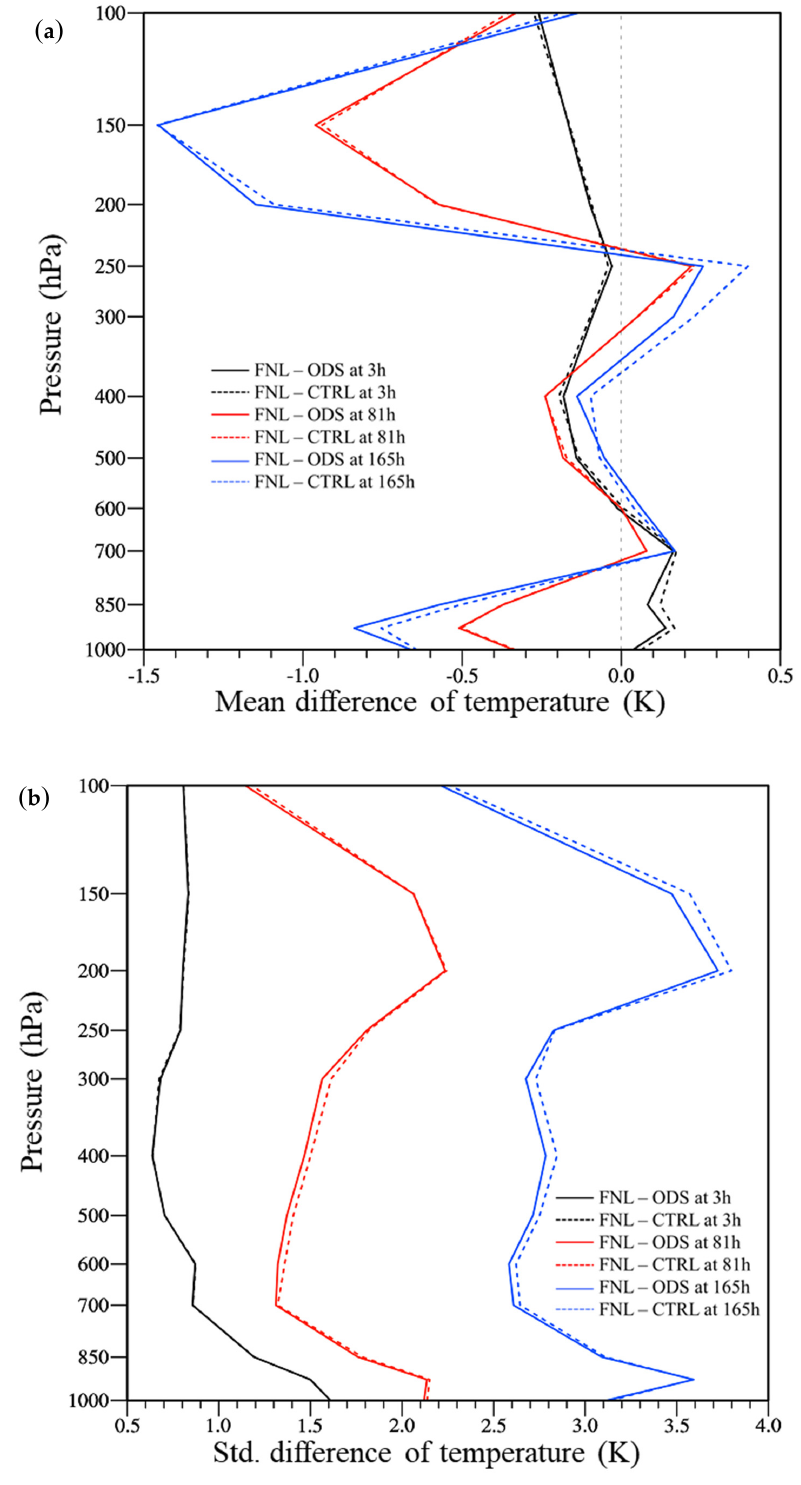
Figure 9. ( a ) Mean biases and ( b ) standard deviations of the vertical di ff erences of temperature between the FNL and forecast data (FNL − ODS, solid lines; FNL-CTRL, dashed) at 3 (black lines), 81 (red lines) and 165 (blue lines) di ff erent forecast times in the region (20–60 ◦ N, 0–360 ◦